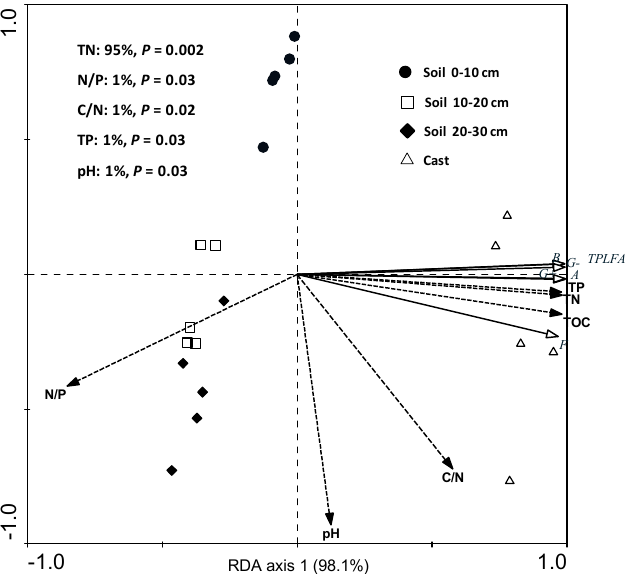
Figure 4. Redundancy analysis of microbial community structure (indicated as phospholipid fatty acids profile) and chemical properties of surface casts and bulk soils. TPLFA, total PLFA; F, fungi; B, bacteria; A, actinomycete; G + , Gram-positive bacteria; G − , Gram-negative bacteria; TOC, total organic carbon; TN, total nitrogen; TP, total phosphorus.